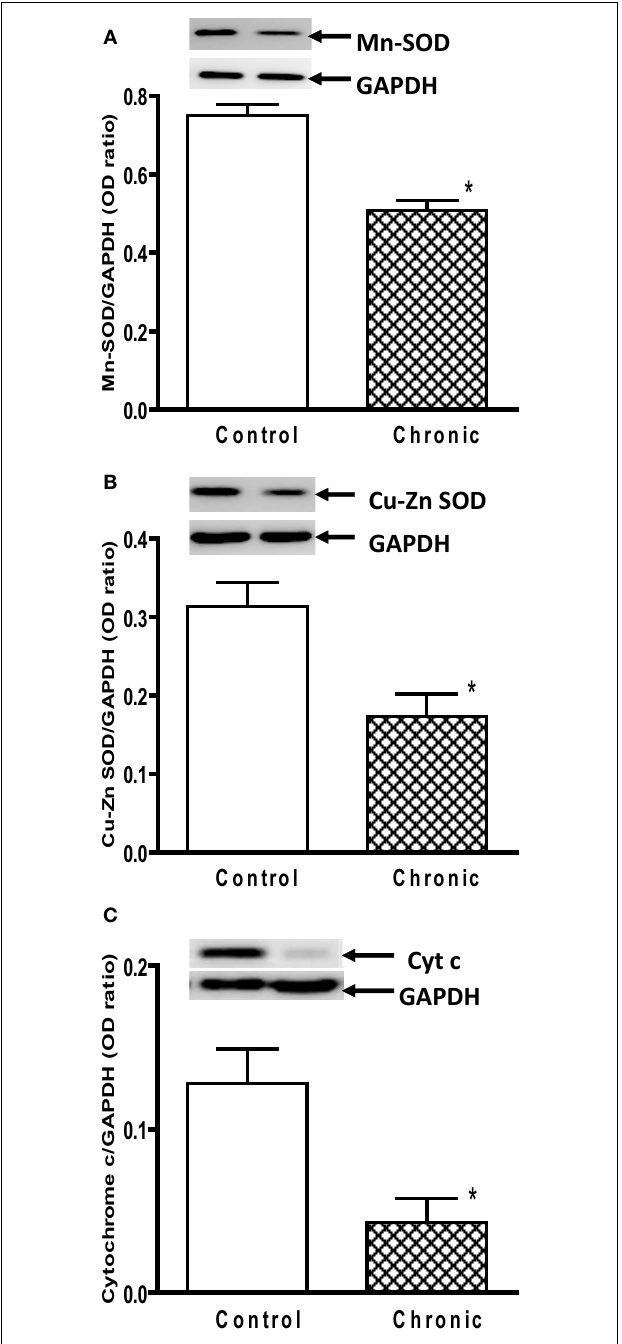
FIGURE 3 | Protein expression of (A) Mn SOD, (B) Cu–Zn SOD, and (C) cytochrome c in the striatum of aged chronic probenecid control and aged chronic MPD mice. A representative image of western blot protein bands was correspondingly shown above each set of bar graph. The protein contents of Mn SOD, Cu–Zn SOD, and cytochrome c were expressed as a ratio to that of GAPDH and each data point represents mean ± SEM, N = 6 per group of animals. Statistical analyses revealed that the levels of Mn SOD, Cu–Zn SOD, and cytochrome c in the striatum of aged chronic MPD 6 weeks after chronic treatment were signifi cantly lower than that of chronic control animals (* P < 0.05).